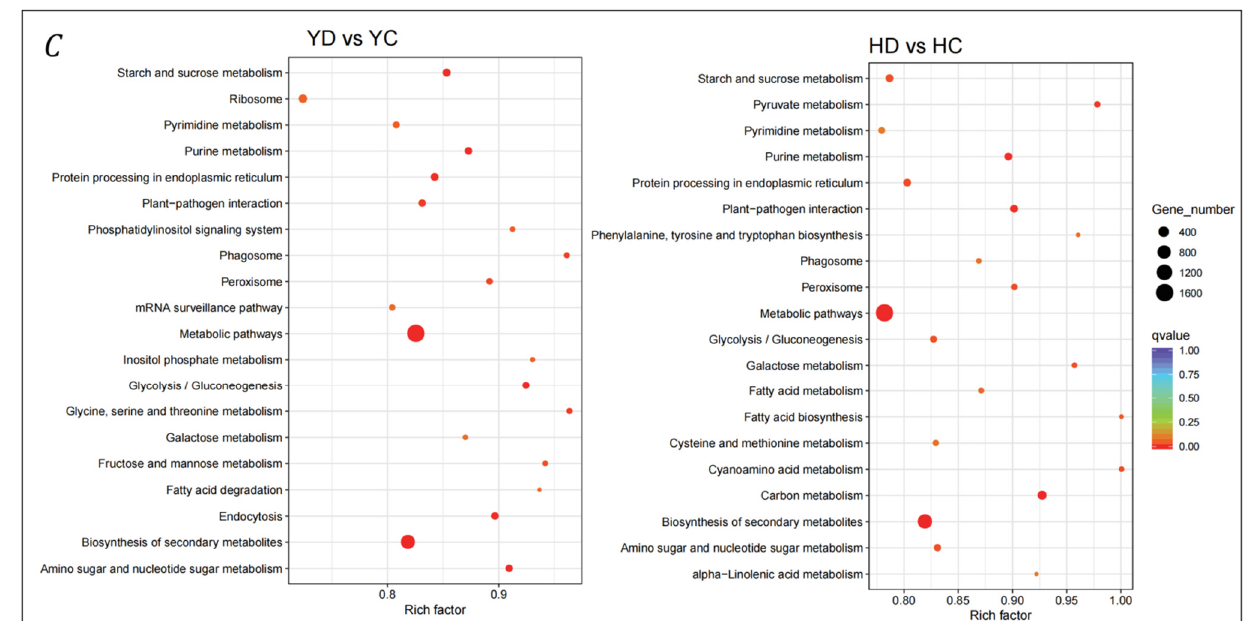
Figure A1. Full-length transcriptome and differential genes overview of HQ and YS10. ( A ): The number of transcriptomes in the two strains. ( B ): The number of differentially expressed genes between each group in the pairwise comparison. ( C ): KEGG pathway analysis of DEGs.